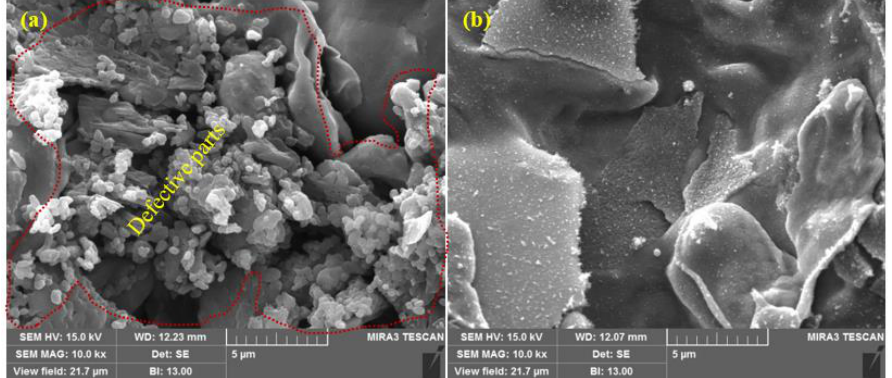
Figure 3. SEM images of the zinc coating deposited by the ( a ) arc thermal spray and ( b ) plasma arc thermal spray processes at 10,000× [31].